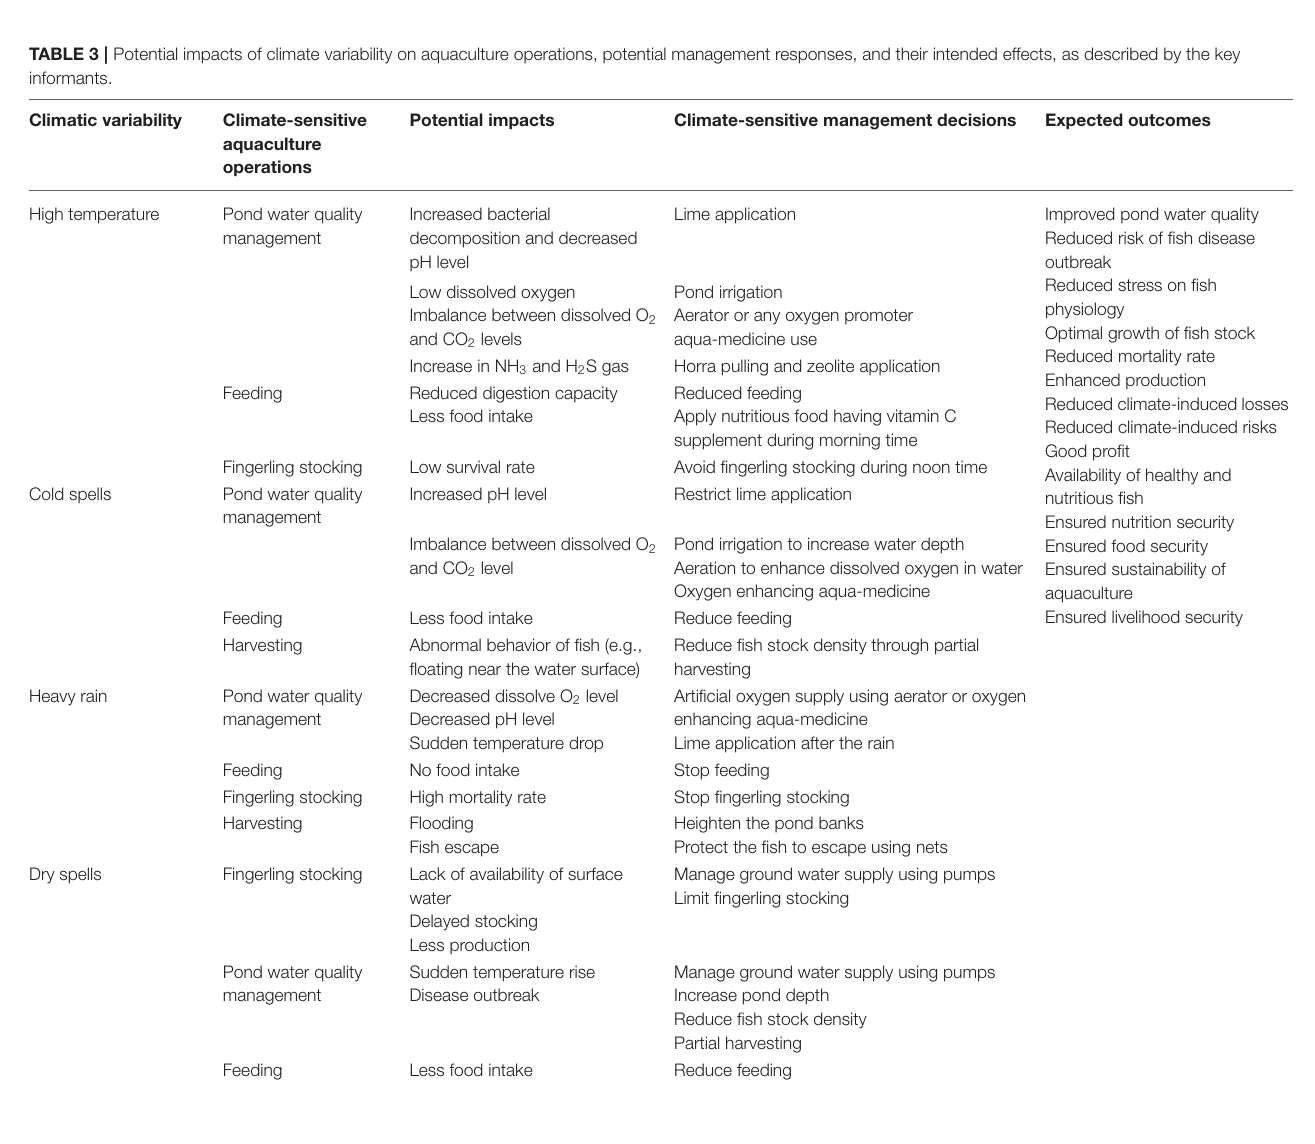
FIGURE 9 | Preferred lead times to make decisions to change management practices and preferred platforms for climate information services delivery.